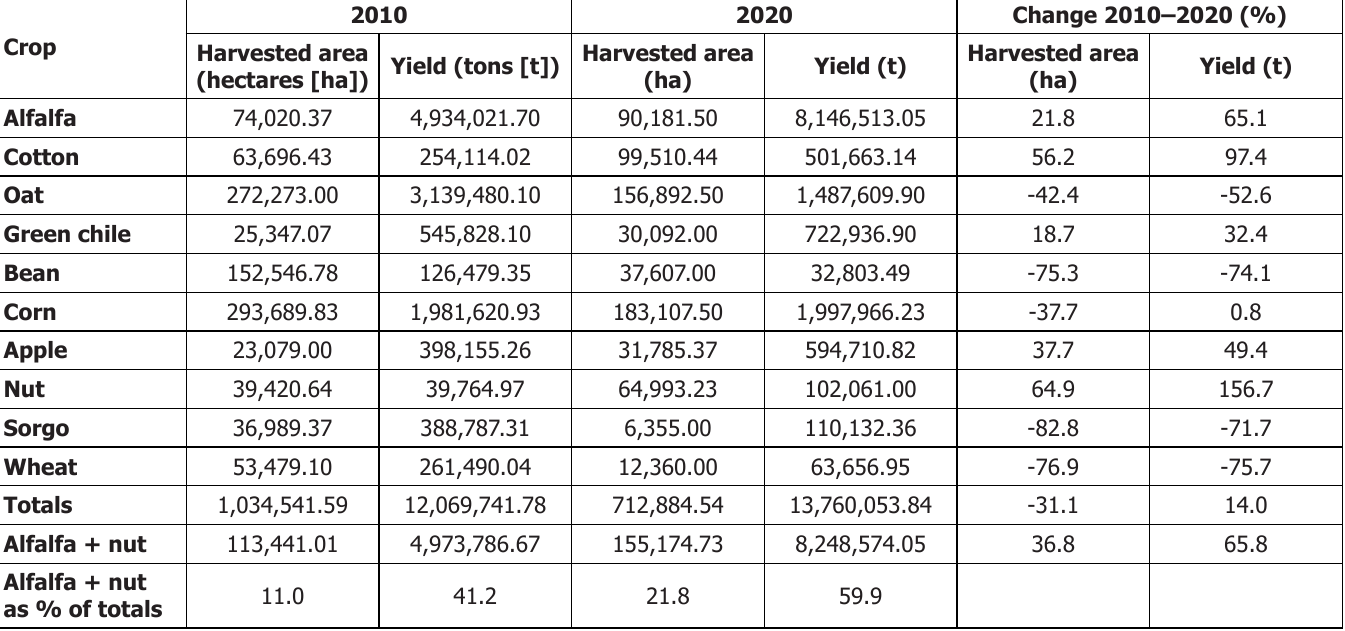
Table 5. Chihuahua main agricultural products,